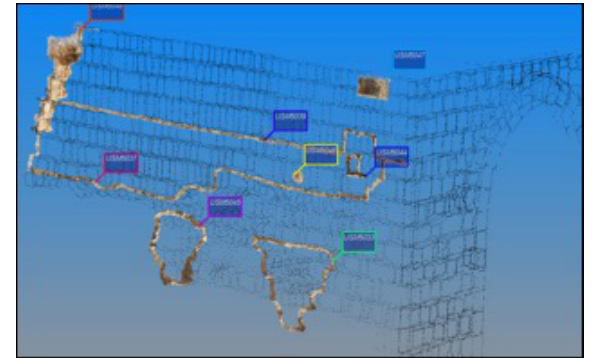
Figure 5. Negative USM represented by the set of 3D points extracted using the perimeters designed on the photographs by